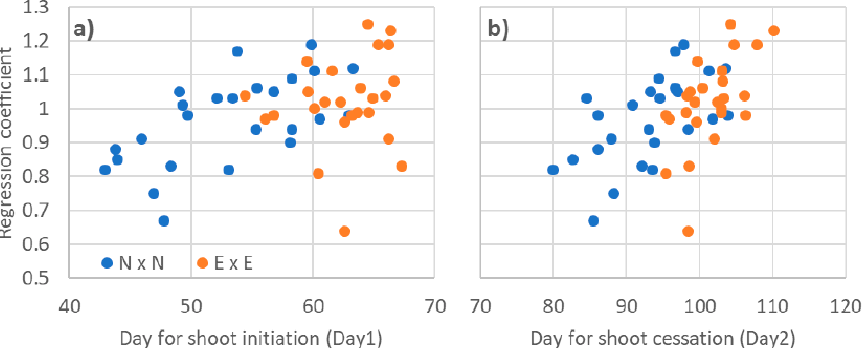
Figure 4. Plot of regression coefficients estimated for families against the days of shoot growth initiation (Day1) ( a ) and cessation (Day2) ( b ), day number after May 1 (sites 1–7). N × N families are blue and the E × E families are orange.